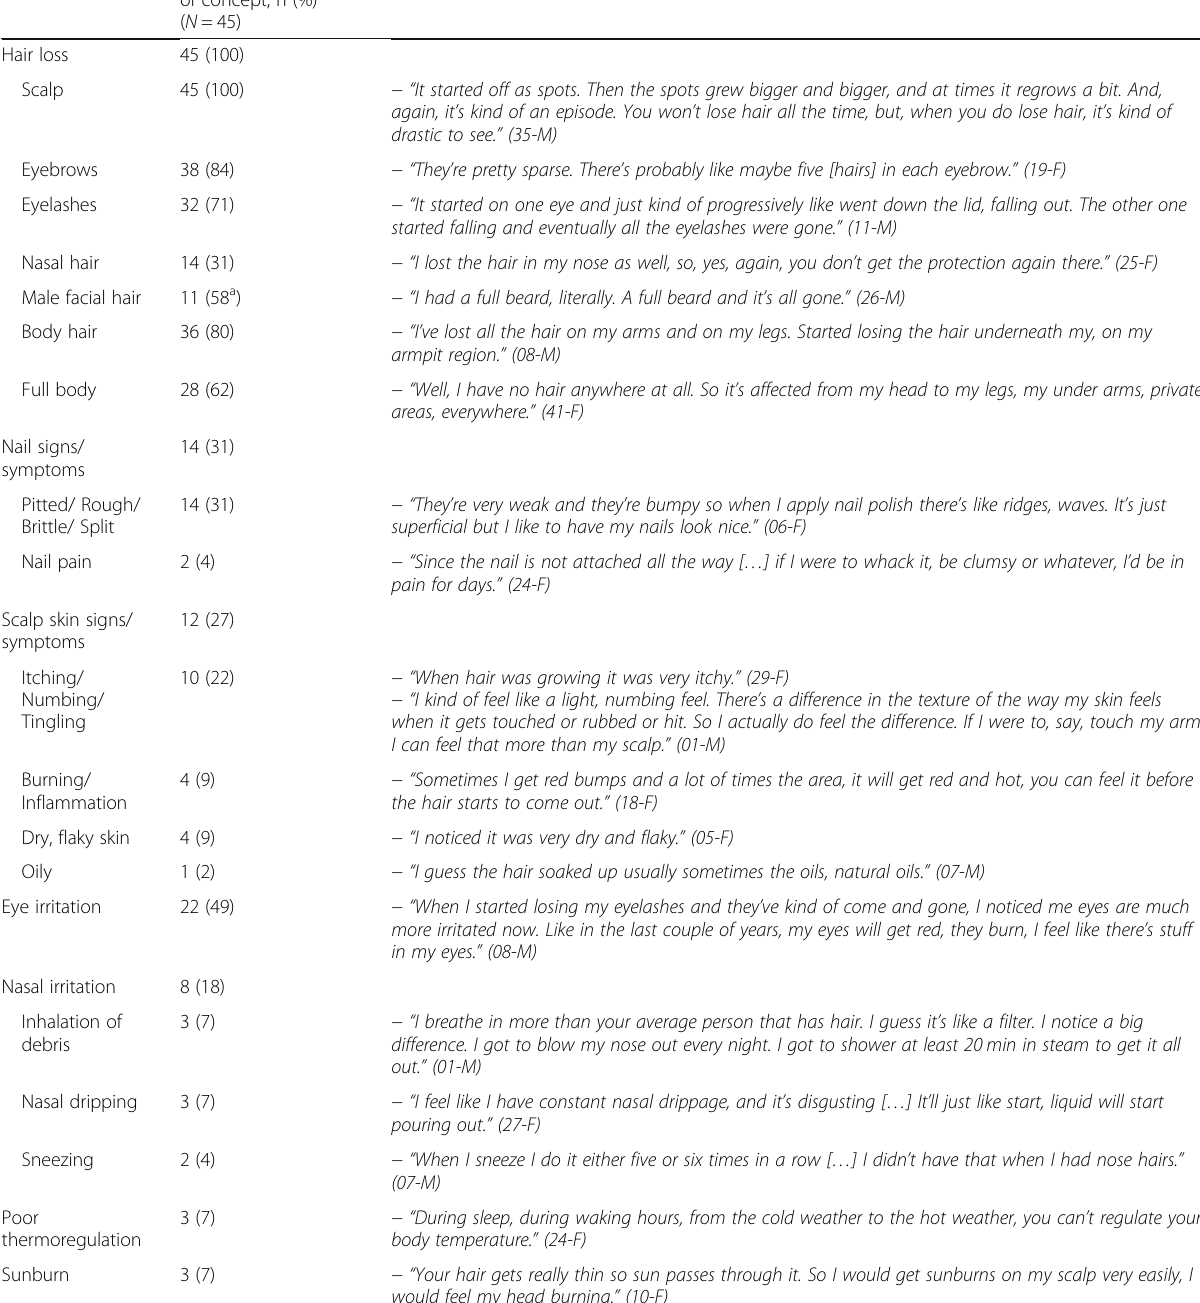
Table 3 Signs/symptoms and physical impacts of AA Concept Patients with experience of concept, n